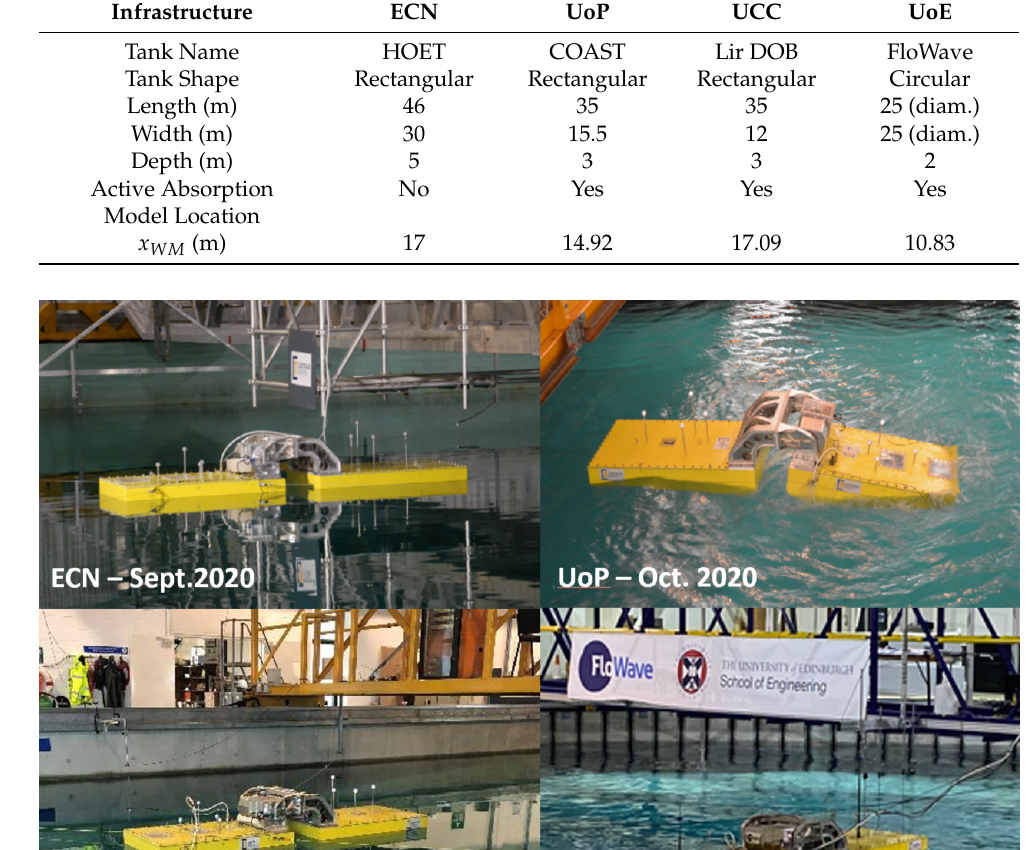
Table 3. Features of the test facilities including the key length introduced in Figure 3. The distance x WM is measured from the wave makers (WMs) to the centre of Raft 1.